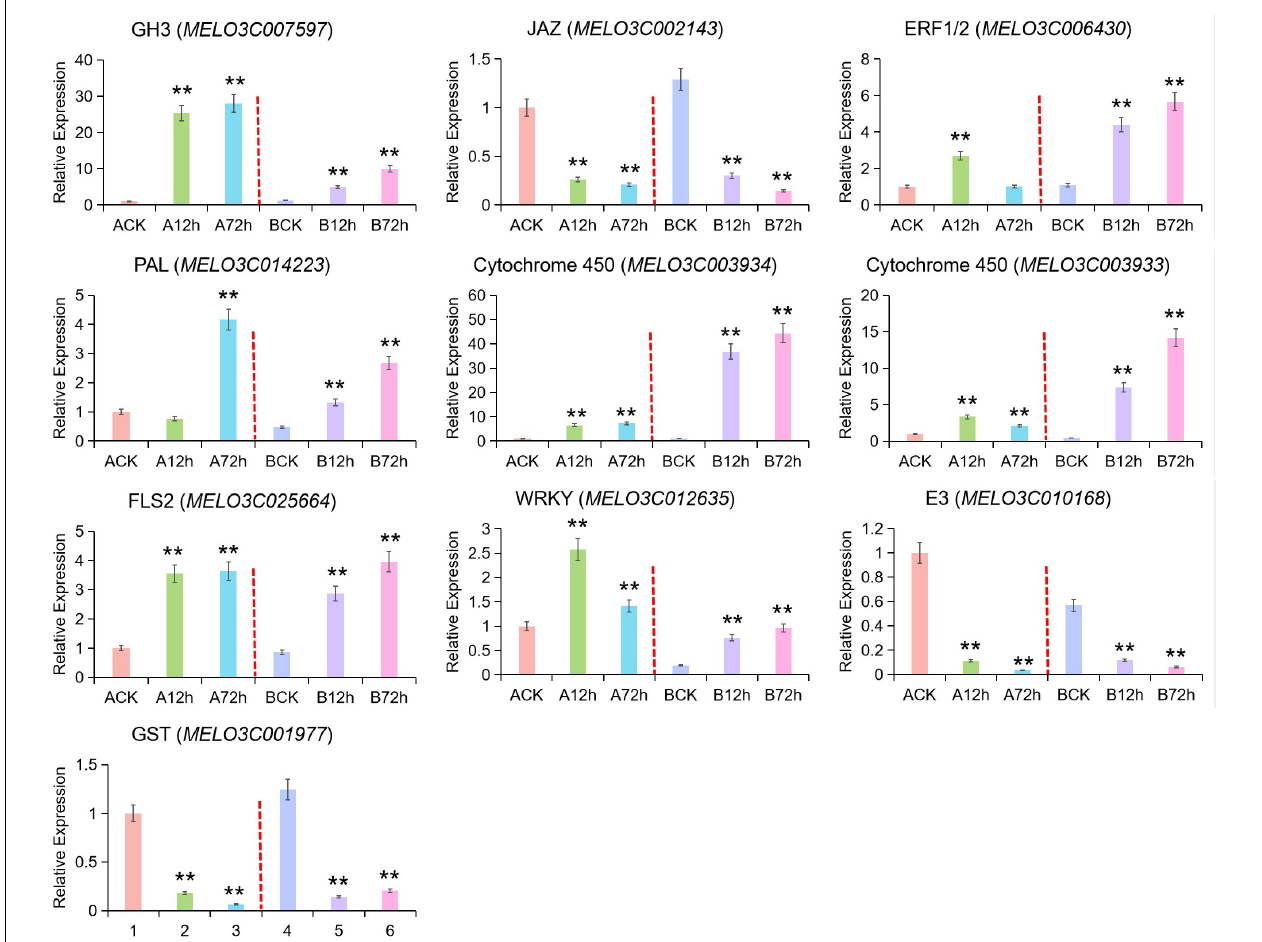
FIGURE 5 | qRT-PCR validation for candidate DEGs across RNA-seq data. Asterick symbol (**) is representing the significant results at ** p < 0.01 level,